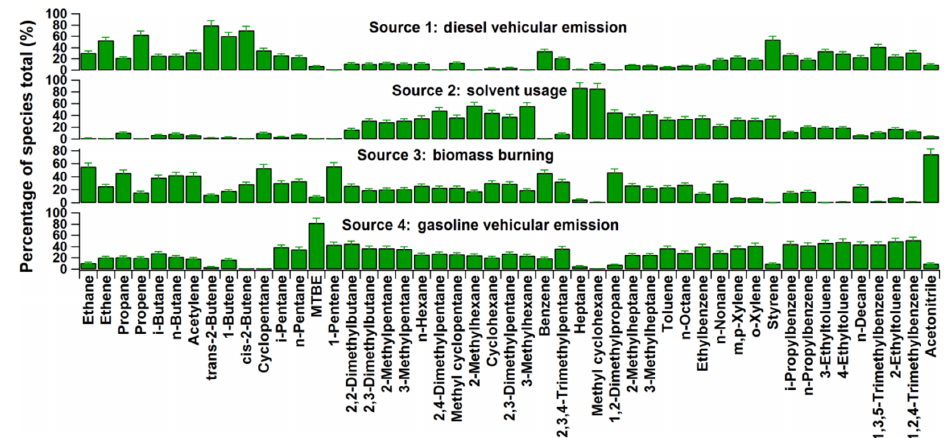
Figure 5. Factor profile (% species total) attributed from positive matrix factorization (PMF).